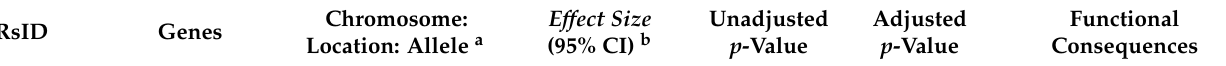
Table 4. Association analysis in the validation